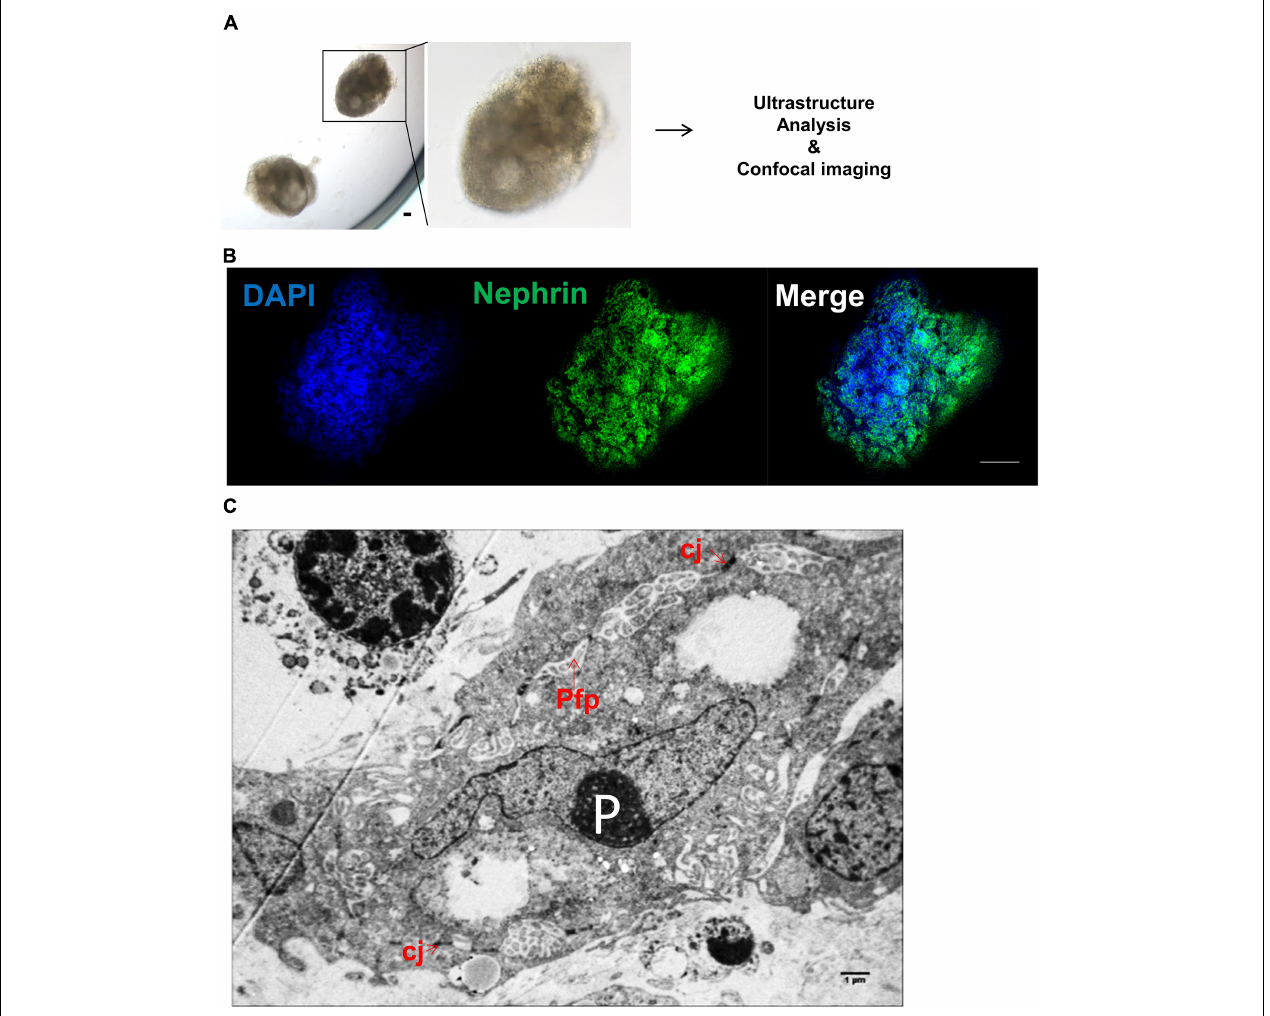
FIGURE 3 | Characterization of human induced pluripotent stem cell (iPSC)-derived kidney organoids. (A) Optical image of iPSC-derived kidney organoids at day + 14. Scale bar: 100 µ m. (B) Confocal analysis and whole-mount staining for Nephrin in iPSC-derived kidney organoids showing nephron vesicles. Scale bar: 50 µ m. (C) Representative electron microscopy image of podocytes in iPSC-derived kidney organoid at day + 14 showing P, podocytes; Pfp, podocyte foot process; and cj, cell-cell junctions. Scale bar: 1 µ